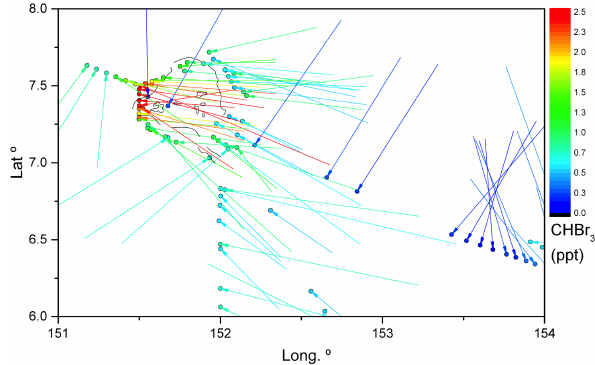
Figure 7. Localised island influence from Chuuk Atoll. Circles de- pict WAS sampling sites, and arrows show instantaneous wind di- rection and speed; both are coloured by CHBr 3